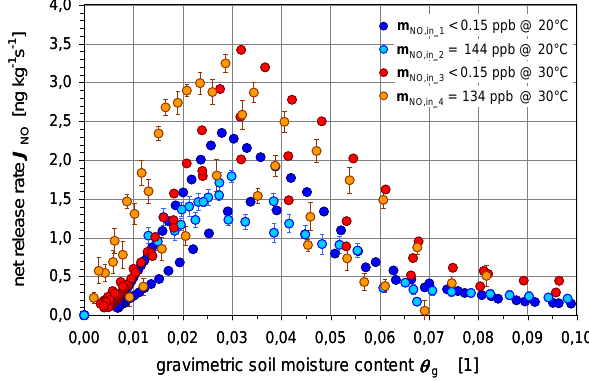
Figure 5. Results of two replicate NO net release rate ( J NO ) mea- Fig. 5: Results of two replicate NO net release rate (JNO) measurements performed on surements performed on two individual sub-samples of a organic two individual sub-samples of a organic rainforest soil from Suriname; both ex- rainforest soil from Suriname; both experiments have been per- periments have been performed at T soil = 25°C and m NO,in_1 < 0.15 ppb. formed at T soil = 25 ◦ C and m NO , in_1 <0.15ppb.